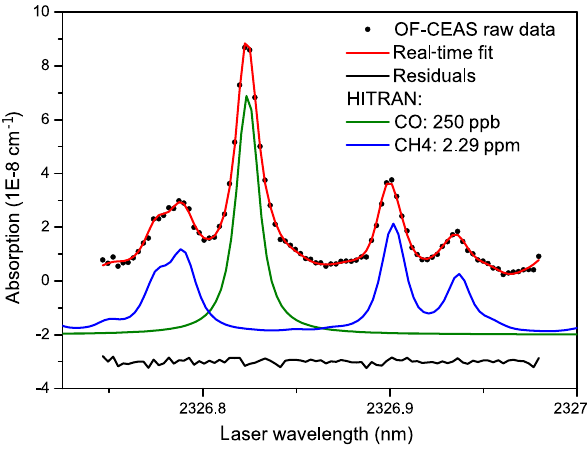
Figure 1. Single OF-CEAS spectra in absolute absorption units, recorded in 150ms with a gas sample at a pressure of 200mbar and a temperature of 295K. CO and CH 4 concentrations are deduced from the real-time fit. The standard deviation of the residuals is 9 × 10 − 10 cm − 1 (in absorption units). The base line has been sub- tracted for comparison with HITRAN-simulated absorption spec- tra (Rothman et al., 2013). HITRAN spectra and the residuals have been offset for